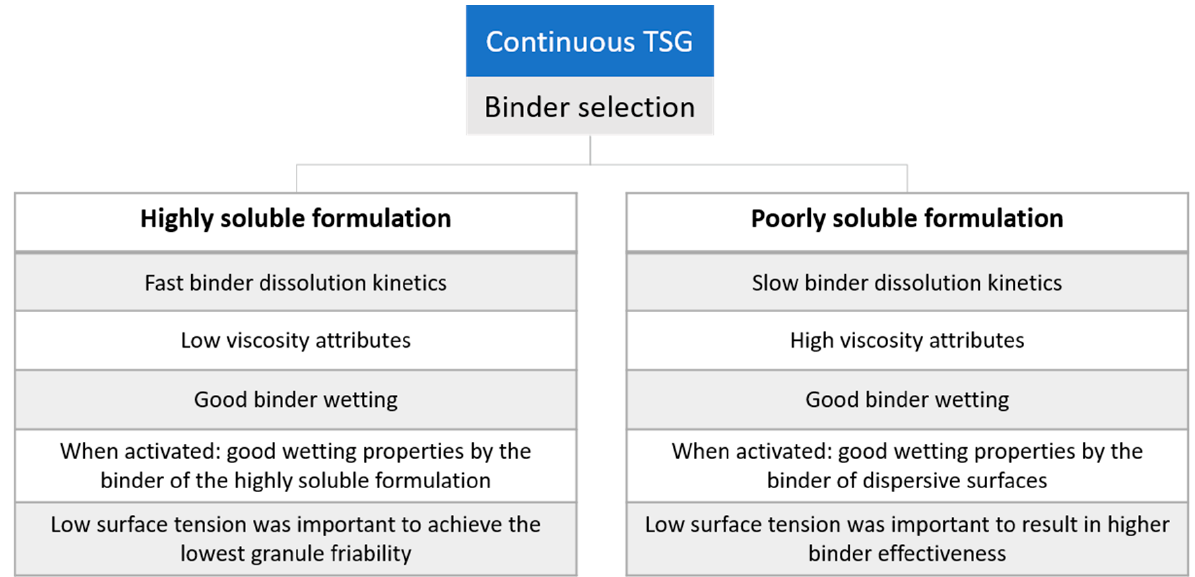
Figure 9. Concise overview of the critical binder attributes influencing the binder effectiveness for a poorly and highly soluble formulation.